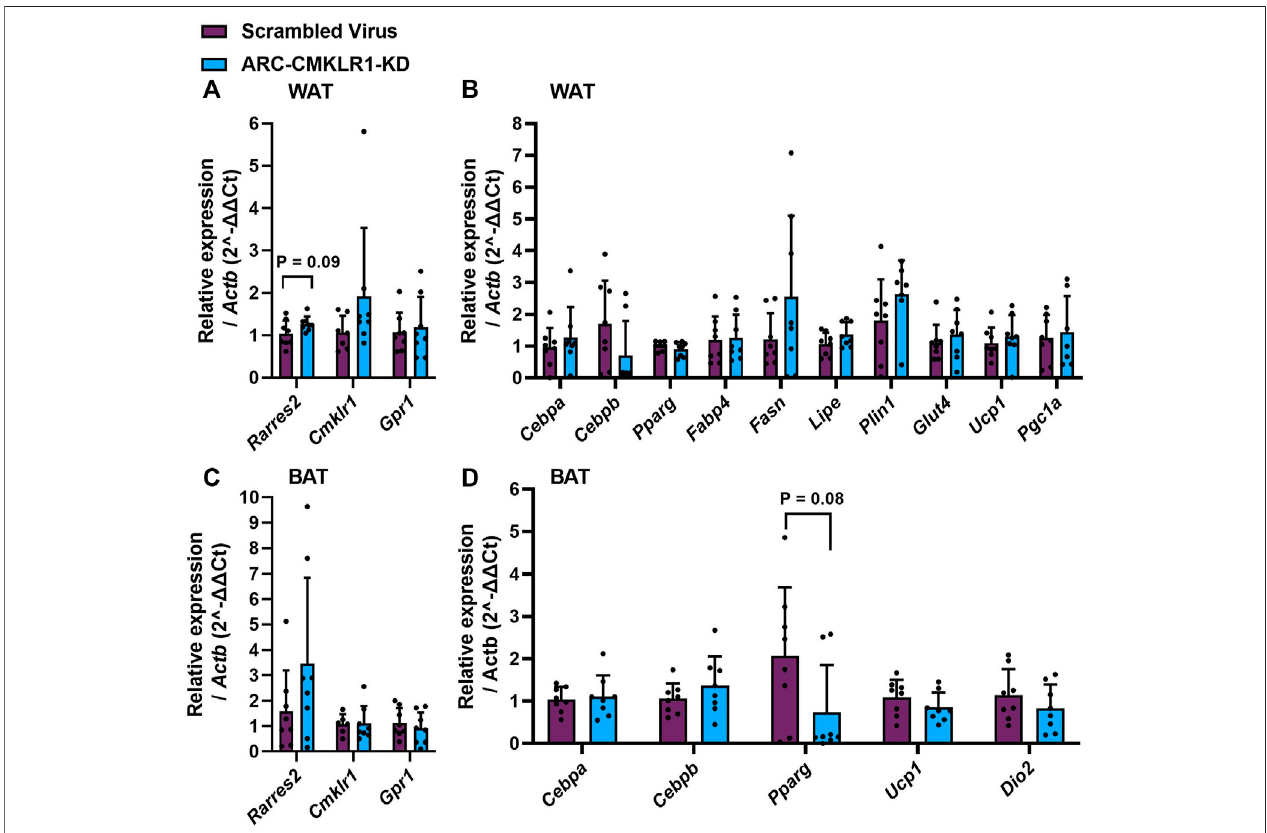
FIGURE 5 | Gene expression of chemerin (Rarres2), its receptors, adipocyte differentiation, function and browning markers in white and brown adipose tissue. AdultSpragueDawleyratsonhigh-fatdietreceivedabilateralinjectionofashRNAconstructtargetedagainstCMKLR1oracontrolconstruct( n =8/group)/Aftersurgery, theratsweremaintainedonahigh-fatdietfor17 daysandthenswitchedtochowdiet. (A) Whiteadiposetissue(WAT)expressionofchemerin(Rarres2)anditsreceptors was unaltered in ARC-CMKLR1-KD rats. (B) WAT expression of markers of adipogenesis (Cebpa, Cebpb, Pparg, Fabp4), lipid and glucose metabolism (Fasn, Lipe, Plin1, Glut4), and markers of browning (Ucp1, Pgc1a) remained unaltered in the ARC-CMKLR1-KD rats. (C) In brown adipose tissue (BAT) chemerin pathway mRNAs were unaltered in ARC-CMKLR1-KD rats. (D) BAT markers of adipogenesis (Cebpa, Cebpb), mitochondrial biogenesis (Pparg) and non-shivering thermogenesis activation (Ucp1, Dio2) were unaltered in ARC-CMKLR1-KD rats.